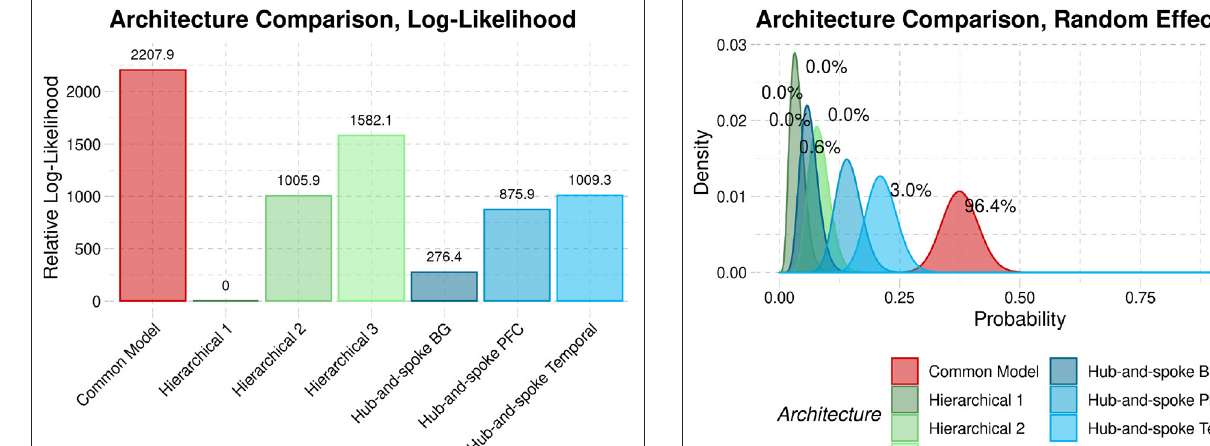
and m 2 is defined as: